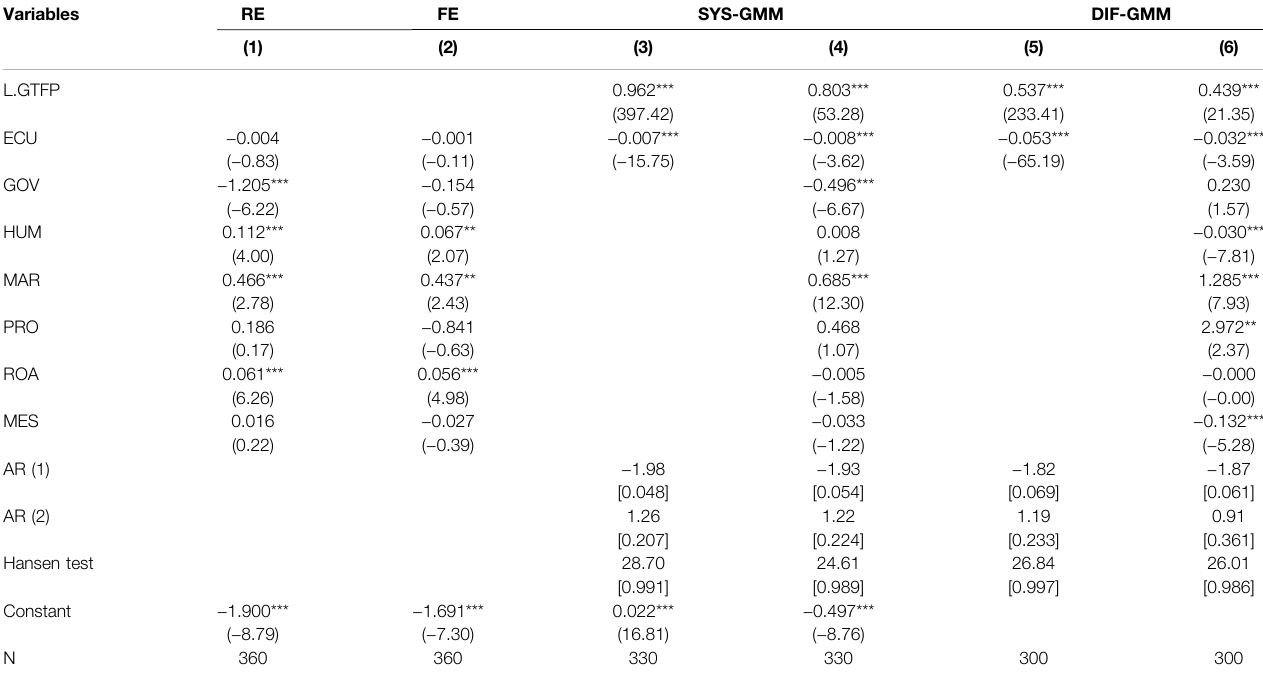
TABLE 5 | Benchmark regression